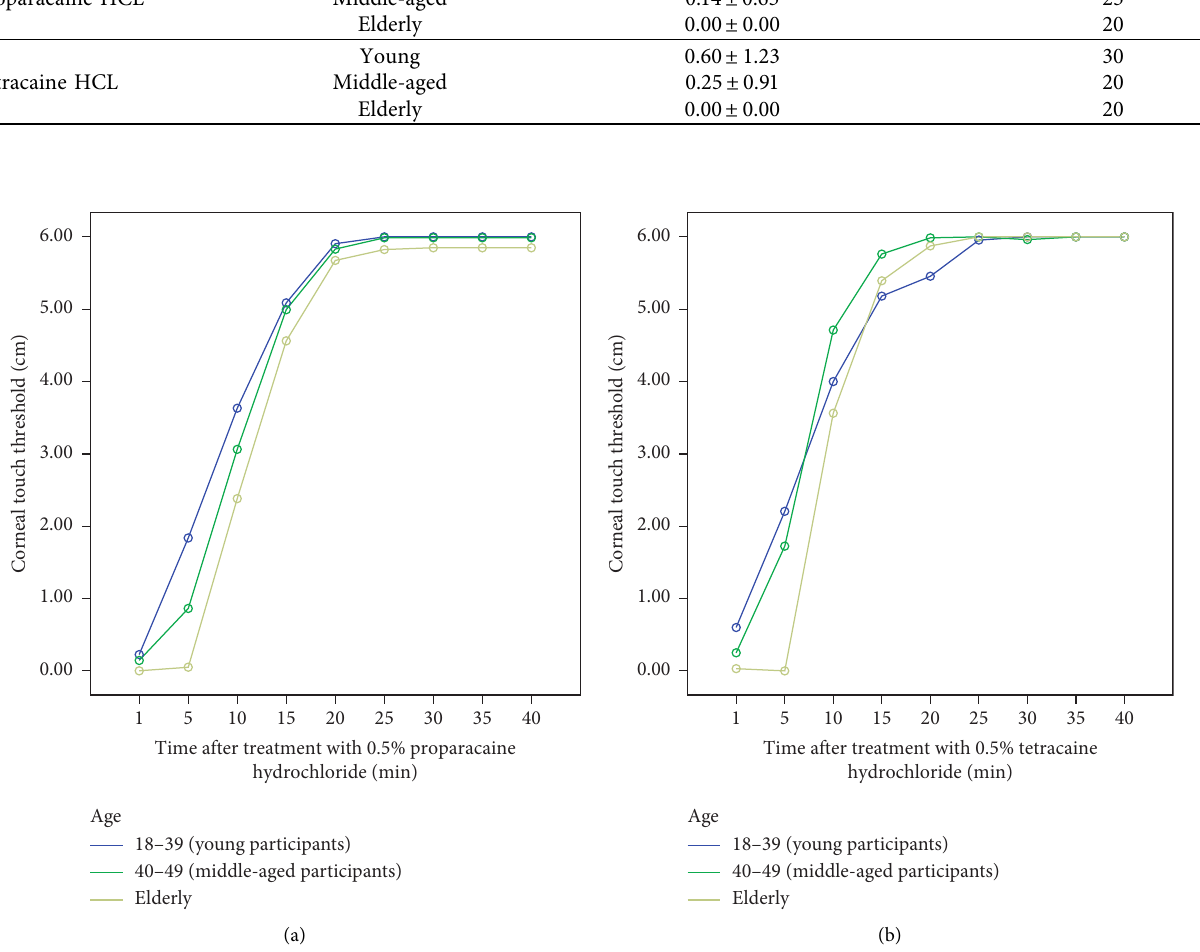
Figure 1: Time course curve showing the effect of age on the onset and duration of actions of (a) proparacaine and (b) tetracaine. Values plotted are mean corneal touch threshold ± standard error of mean ( n � 80). Repeated measures ANOVA followed by post hoc Tukey HSD.